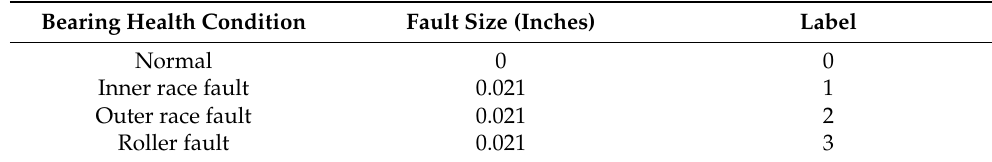
Table 1. Details of the experiment data.